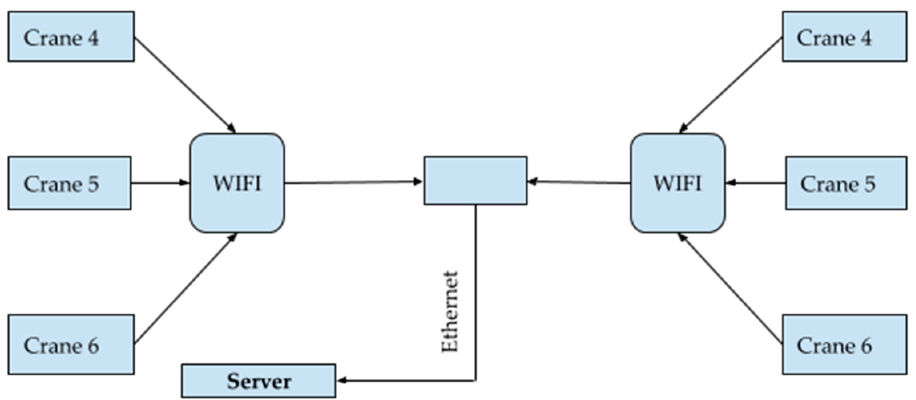
Figure 13. When the crane is moved to the repair area, the crane data is transmitted to the relay node.